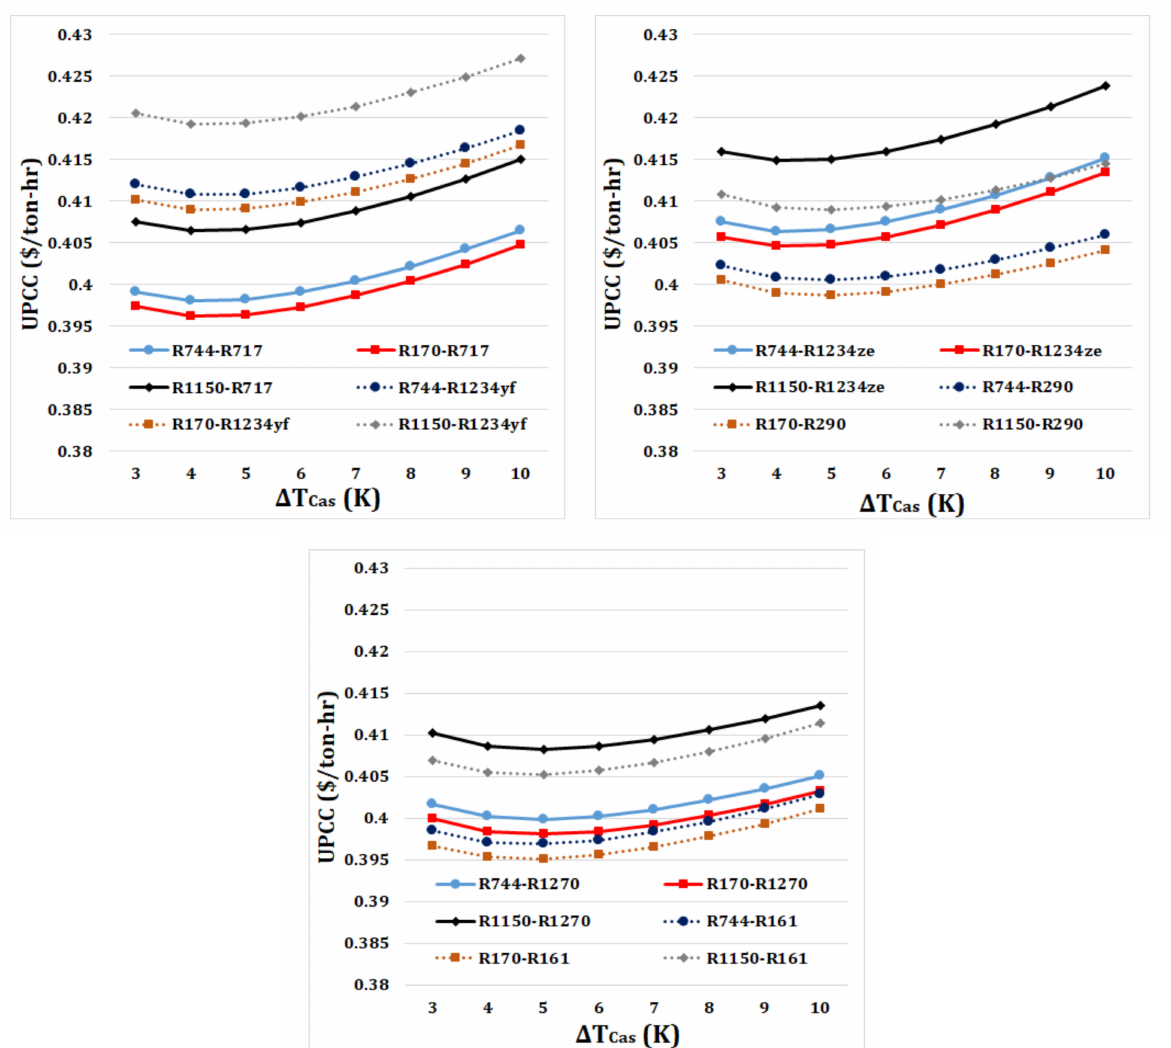
Figure 3. Effect of temperature difference in the cascade heat exchanger ( ∆ T Cas ) on the UPCC for different refrigerant